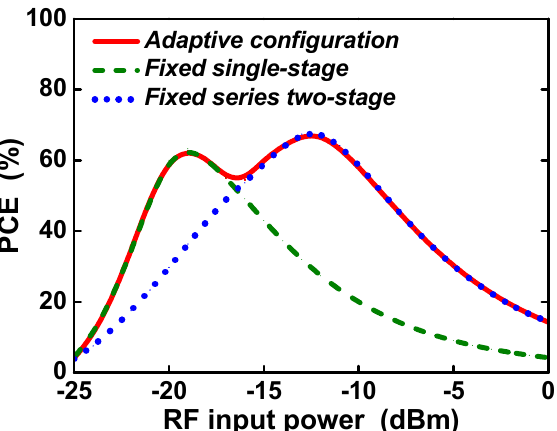
Figure 8. PCE according to RF input power for each rectifier configuration.